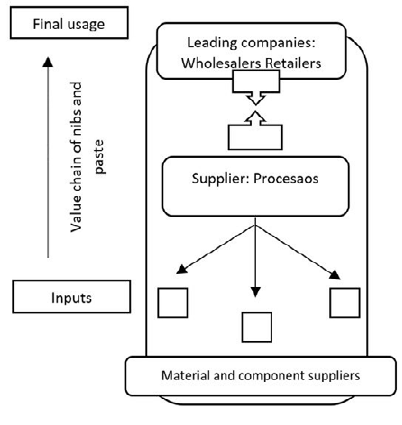
Figure 5. Governance mechanism at Arriba